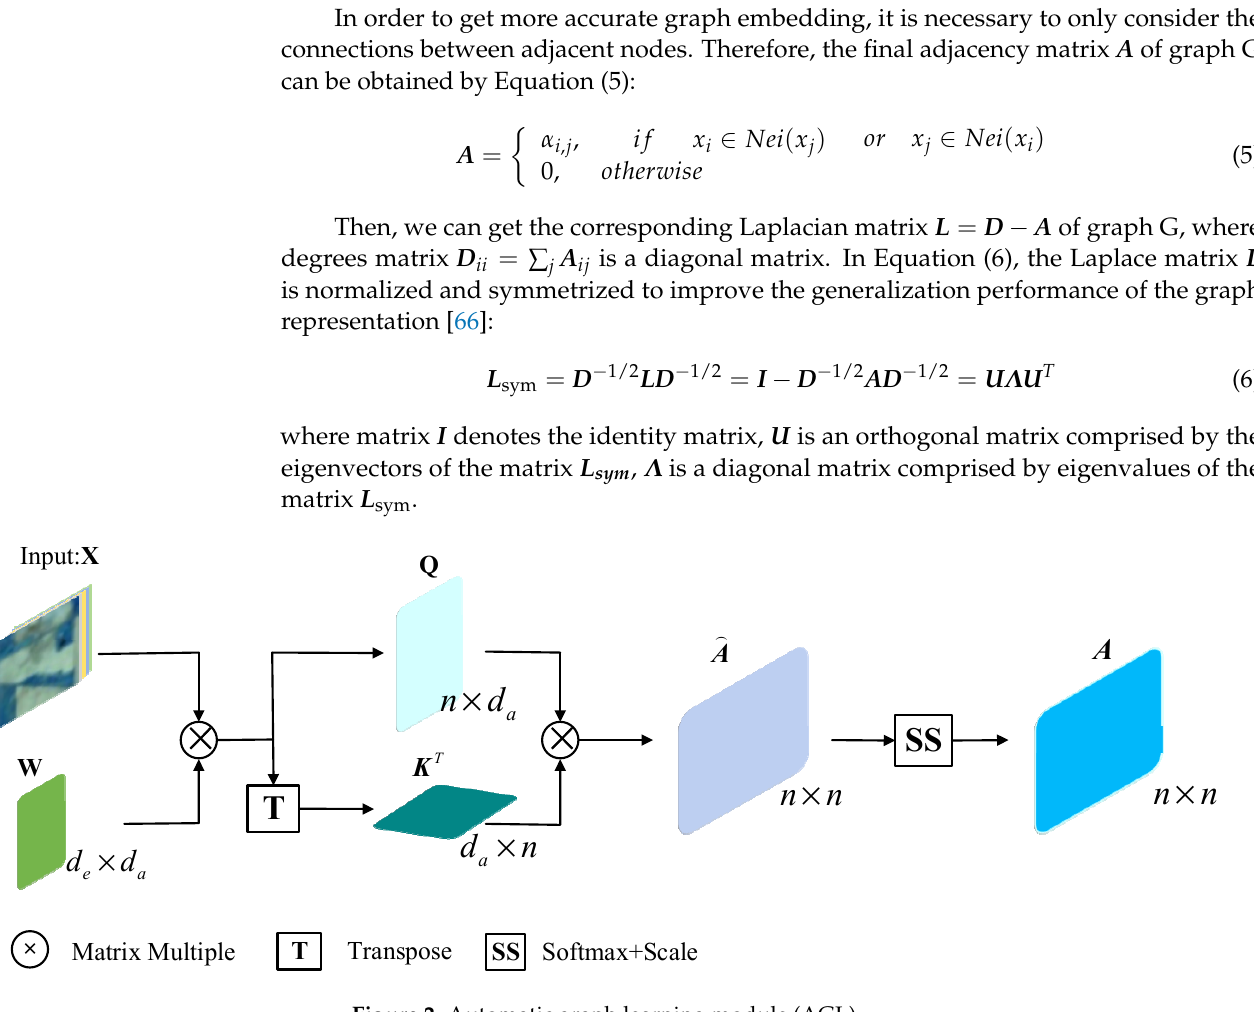
Figure 2. Automatic graph learning module (AGL).